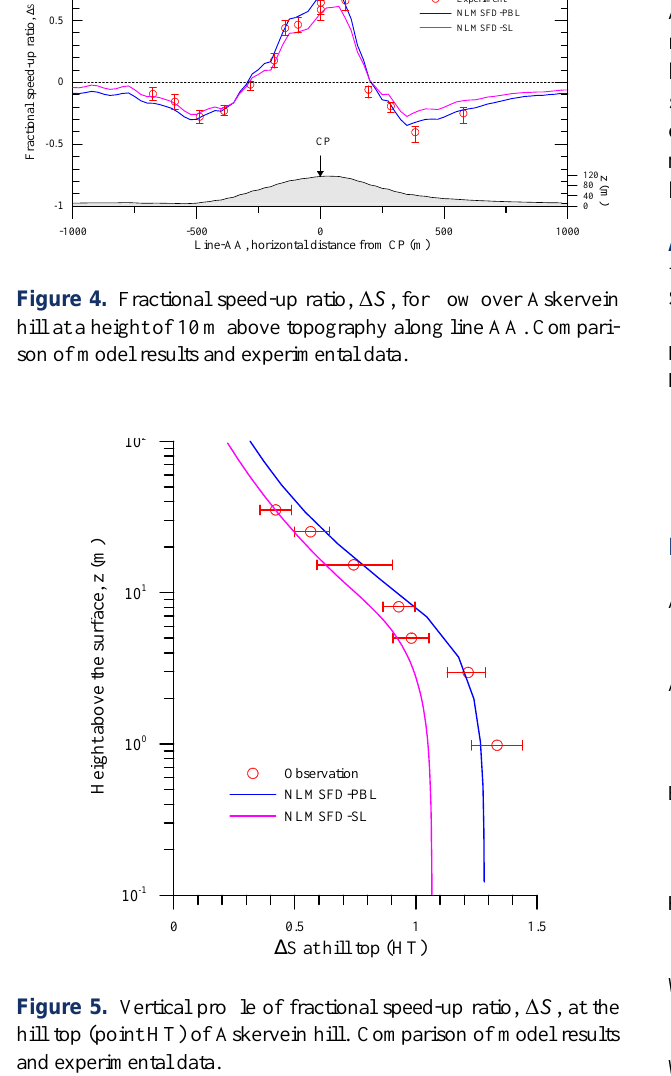
Figure 5. Vertical profile of fractional speed-up ratio, ∆ S , at the hill top (point HT) of Askervein hill. Comparison of model results and experimental data.